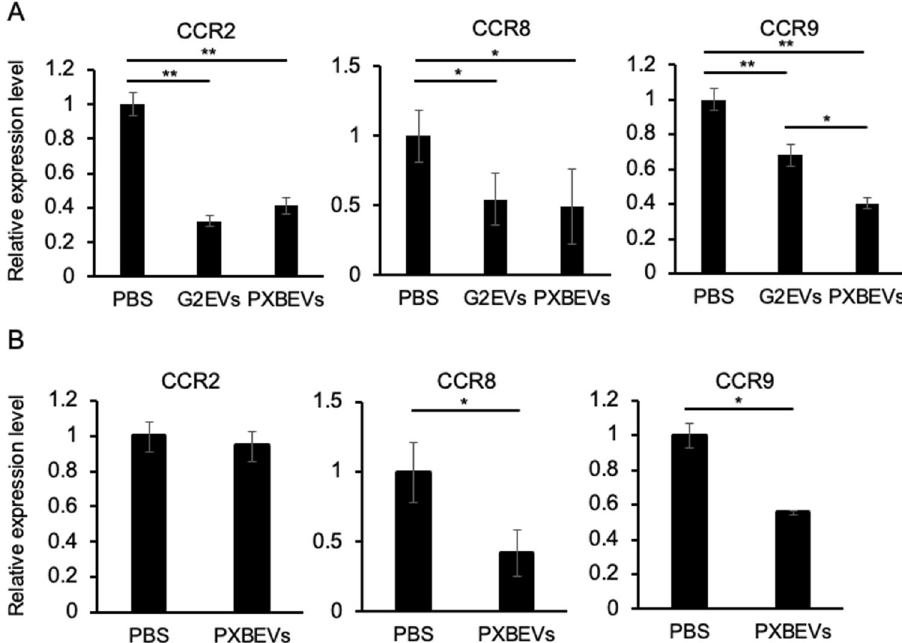
Fig. 6 Hepatocyte-derived EV treatment reduced CCR2, CCR8, and CCR9 expression in BM cells. A CCR2, CCR8, and CCR9 mRNAs in BM cells 12 h after HepG2-EVs or PXB-EVs addition into culture supernatant were measured via real-time (RT-qPCR), and each sample was normalized relative to β -actin expression. Data represent the mean ± SD of triplicate experiments. B CCR2, CCR8, and CCR9 mRNA in BM cells collected from mice 48 h after injection of CCL 4 + PBS or CCL 4 + PXB-EVs were quanti fi ed using RT-qPCR. β -actin was used as an internal control. Data represent the mean ± SD of triplicate experiments. Statistical analysis was performed using one-way ANOVA and subsequent Tukey ’ s HSD method or student ’ s t test. * P < 0.05, ** P <